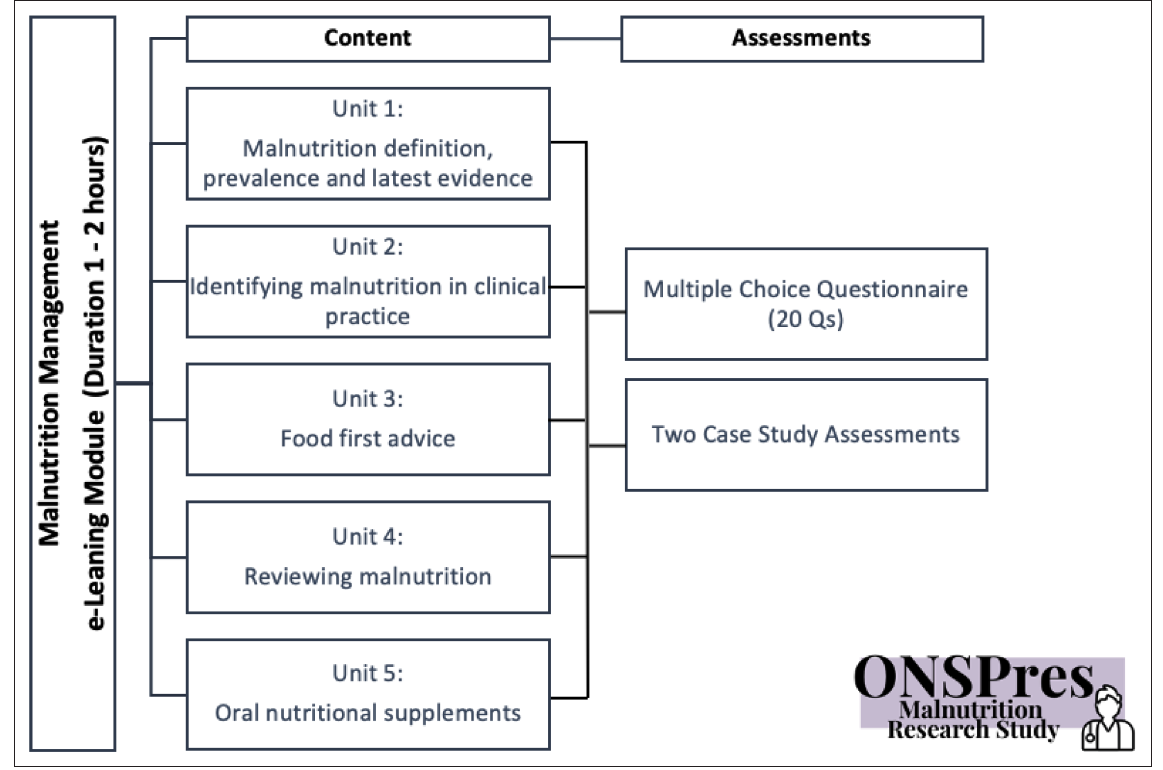
Figure 1 Malnutrition management e- learning module